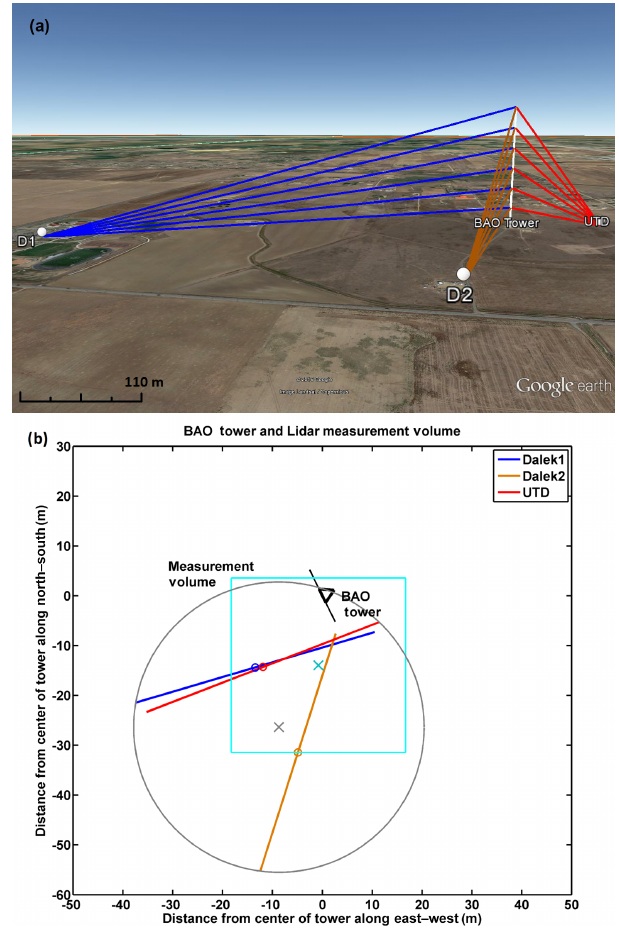
Figure 2. The virtual tower stare (VTS) scan. (a) Schematic of the VTS technique. The blue, red and orange lines indicate beams from each of the three 200S lidars that make measurements at each sonic anemometer level. (b) Location and size of the common volume (cyan box) with respect to the BAO tower. The blue, red and orange lines are range gates from the three 200S lidars that fall within the common volume. The grey circle indicates the estimated measure- ment volume defined by the position of the range